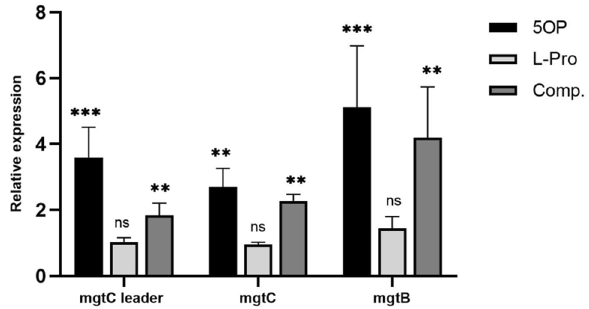
Figure 4. 5OP upregulates the expression of the mgtCBR operon. Three primer pairs were used to quantify different parts of the operon. Shown is the relative expression by wild-type Salmonella exposed for 2 h to 5-OP (5OP), l-proline (l-Pro), or both at a 1:10 ratio (8 mM 5OP and 80 mM l-proline, Comp.) and normalized to DDW control cultures. Shown is the average of three experiments performed. One-Way ANOVA was conducted. ***P < 0.001, **P < 0.01, ns not significant. Geometric mean and standard error of mean are